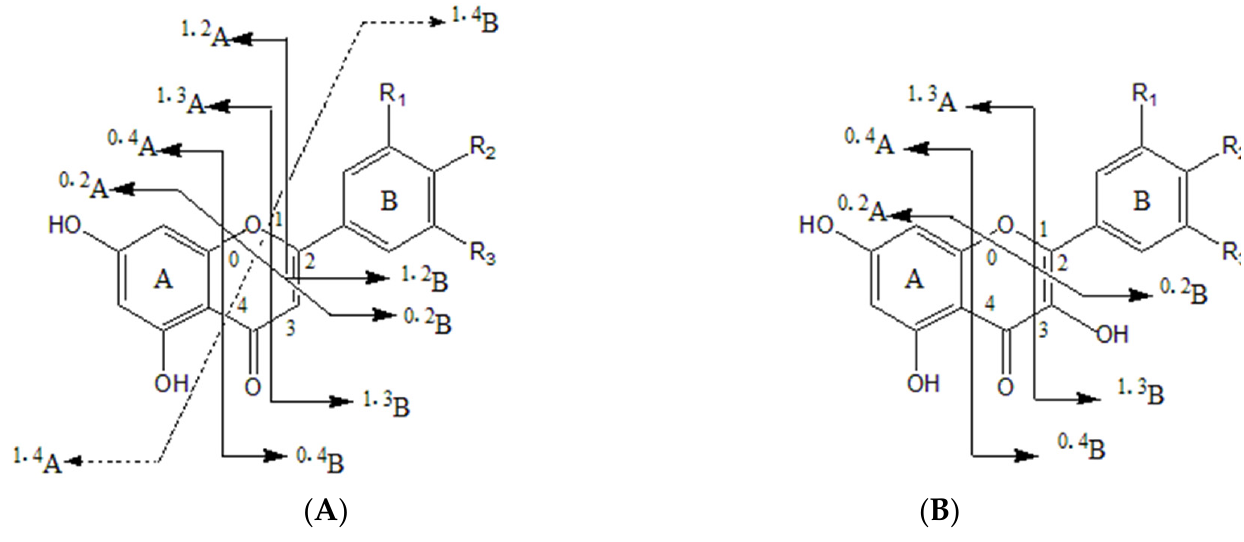
Figure 3. Schematic diagram of the fracture site of ( A ) flavonoid and ( B ) flavonol aglycone in negative ion mode.